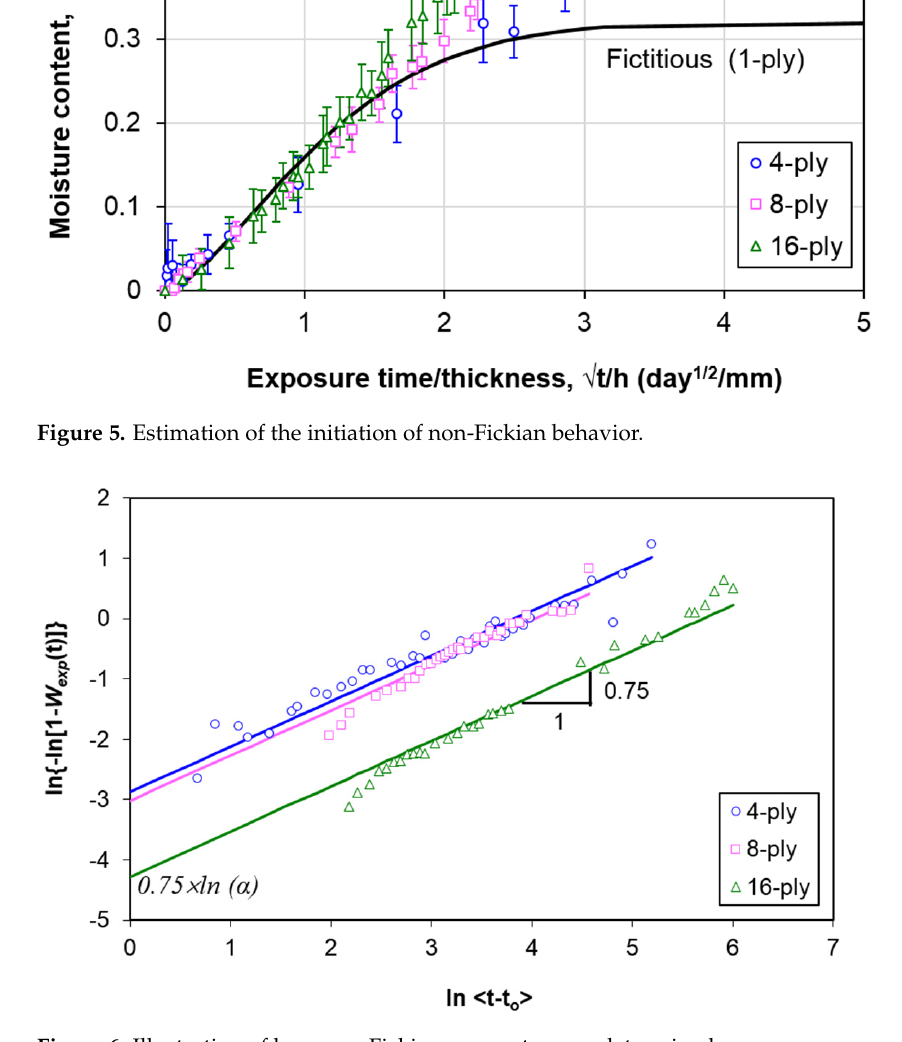
Figure 6. Illustration of how non-Fickian parameters are determined. Table 2. Non-Fickian parameters of AS4/8552 carbon/epoxy composites.